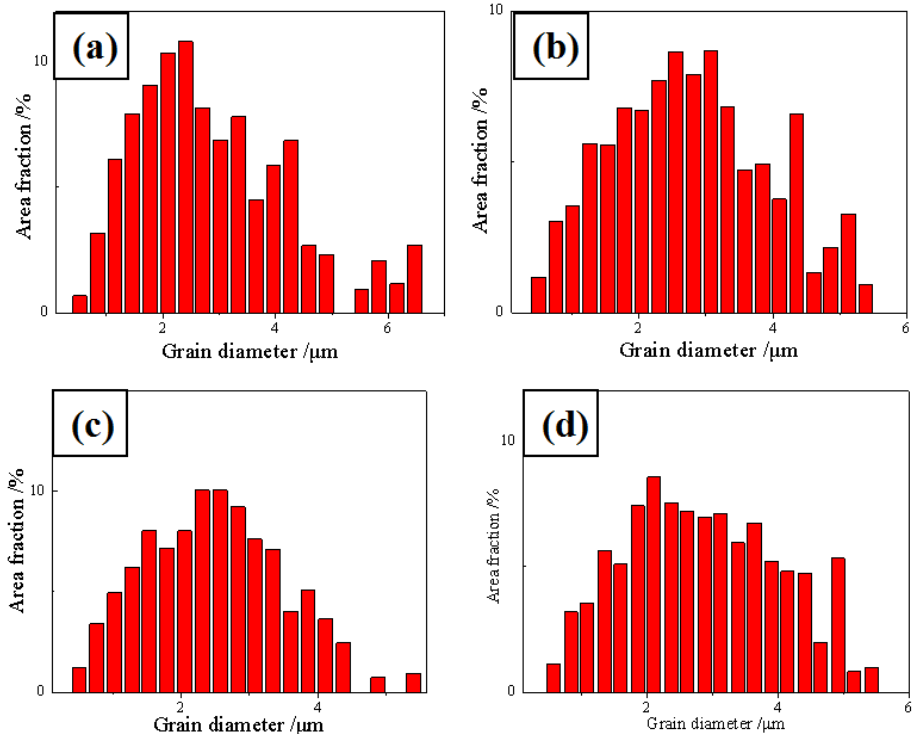
Figure 2. Grain size distribution of FeCrAl ODS steels with different Zr contents: ( a ) 0 wt.%, ( b ) 0.3 wt.%, ( c ) 0.6 wt.%, ( d ) 1.2 wt.%.